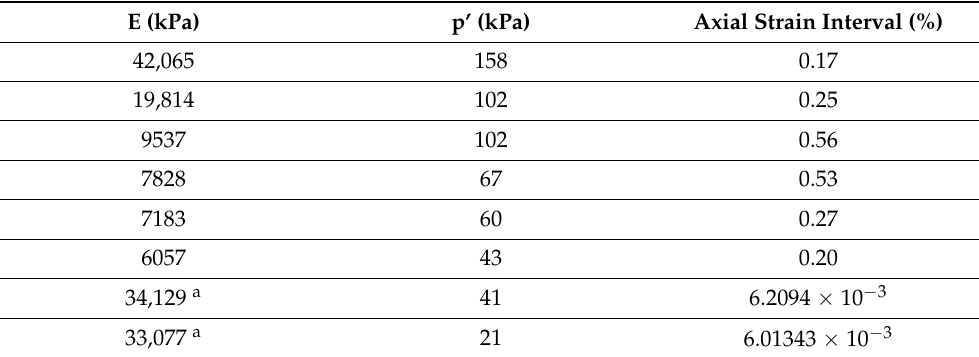
Table 1. Young modulus values of DNA-1A for different confining pressures and strain intervals of measurement (Replotted with permission from Marzulli and Cafaro ©2019 American Society of Civil Engineers. Permission conveyed through Copyright Clearance Center,